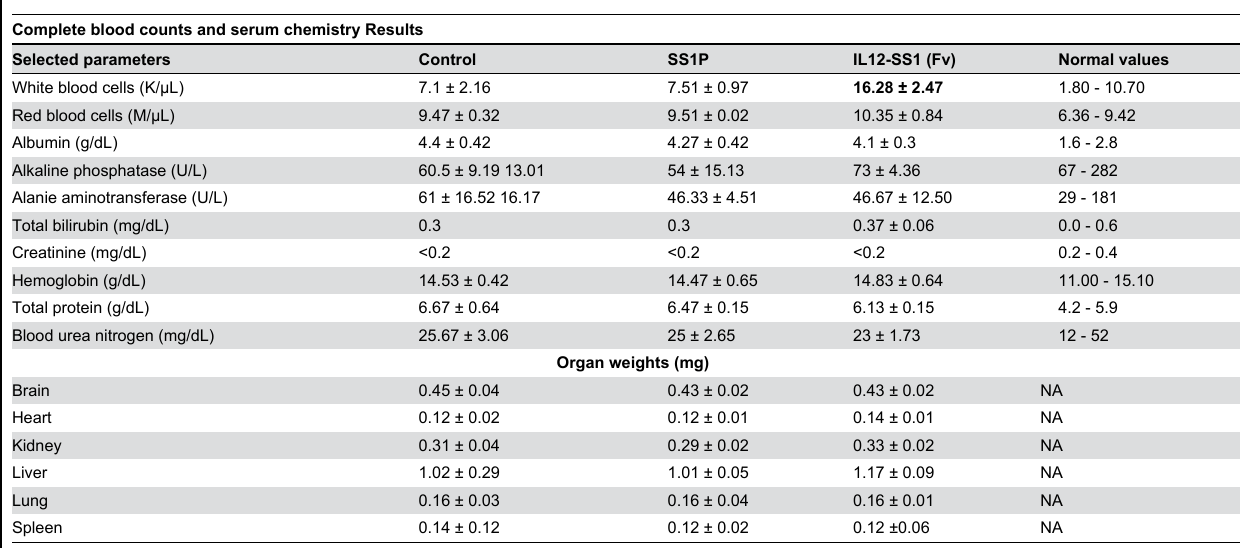
Table 2. Selected in vivo toxicological results and organ weights.